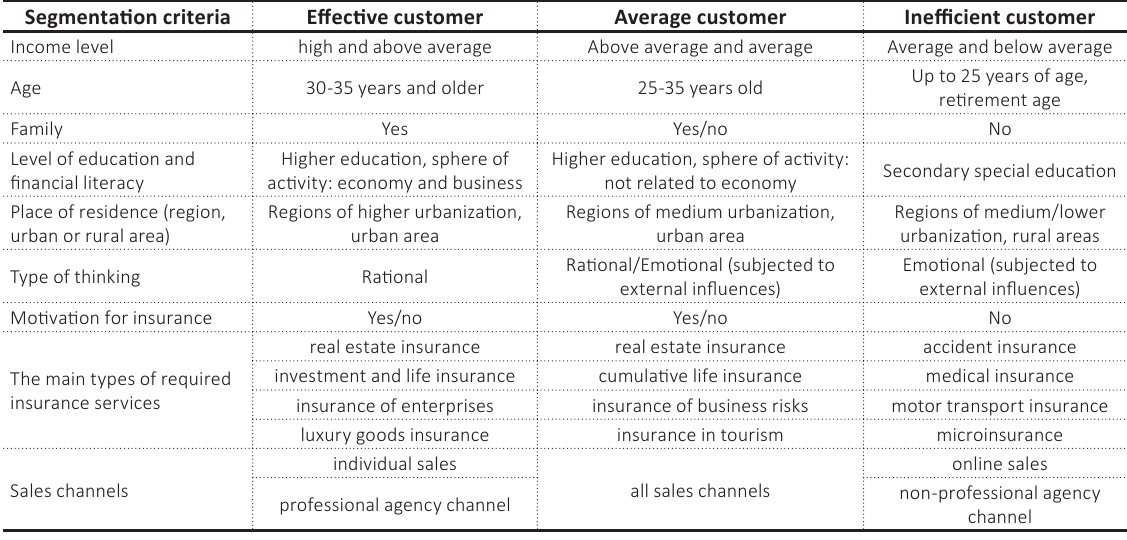
Table 4. Customer characteristics in major insurance